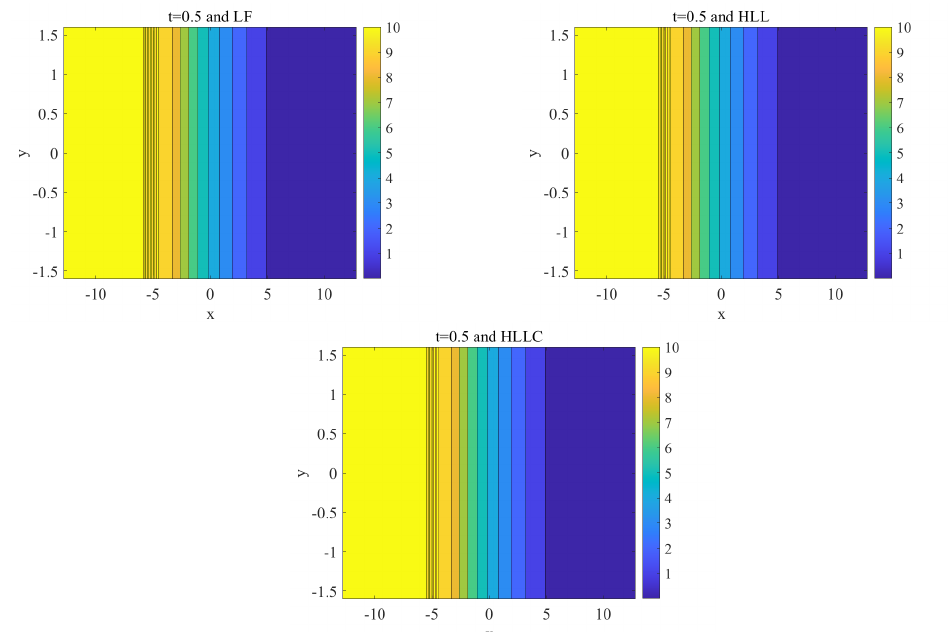
Figure 6. Depth contours of numerical solutions with WENO–LF, WENO–HLL, and WENO–HLLC fluxes for the 2D dam break problem at t =